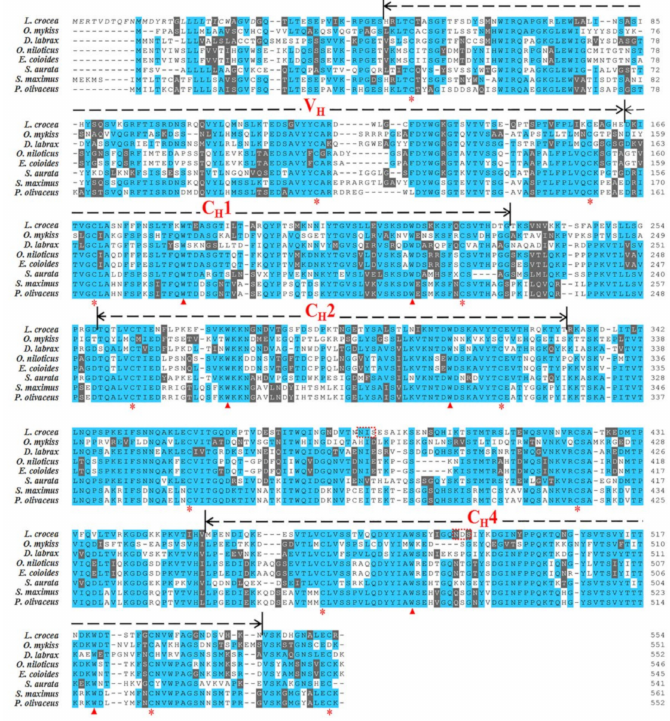
Figure 1. Alignment of the predicted large yellow croaker IgT heavy chain amino acid sequence with other known IgT heavy chain molecules. The conserved amino acids are indicated in blue fill. The predicted signal peptide sequence of large yellow croaker IgT heavy chain is indicated in italics. The C H domains are divided into three domains (C H 1, C H 2, and C H 4). The conserved cysteines and tryptophan are marked with red asterisk and triangle. The first cysteine corresponds to the cysteine required for binding to the light chain. Potential glycosylation sites (NIS and NDS) are shown with a red dotted